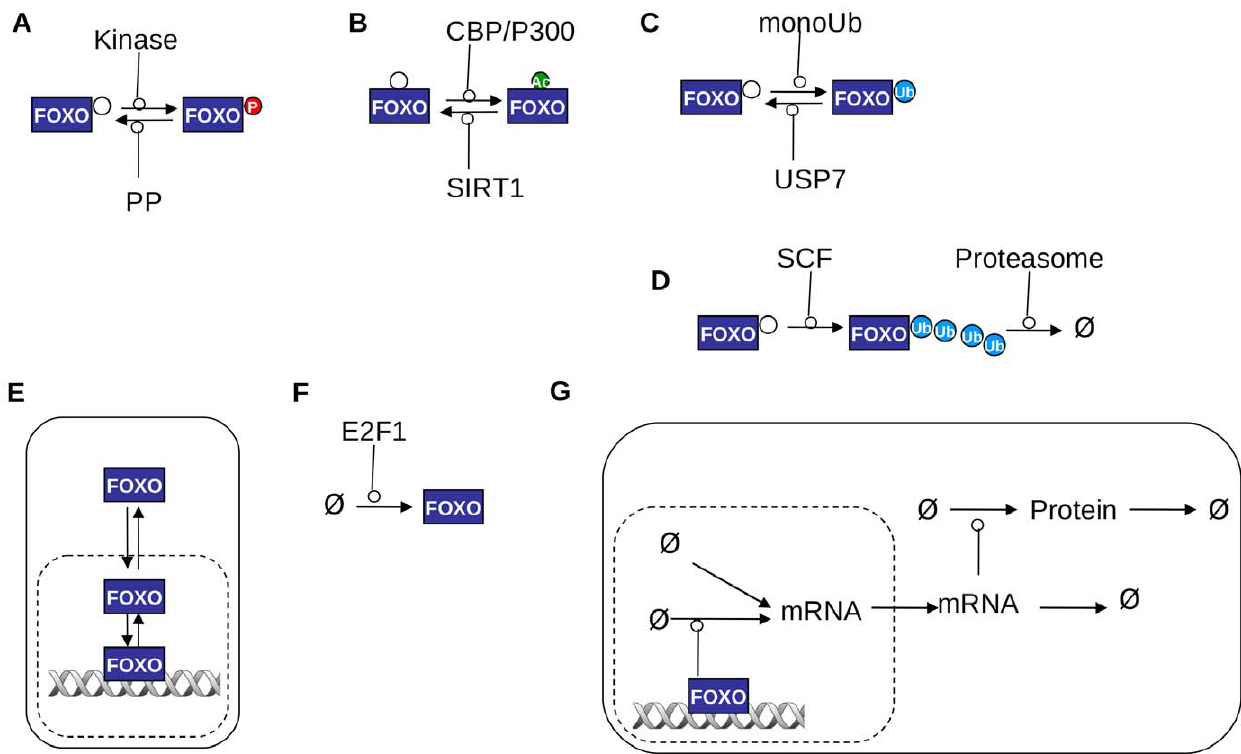
Figure 3. Fundamental reaction types in the model. A: phosphorylation/dephosphorylation; B: acetylation/deacetylation: C: monoubiquitina- tion/deubiquitination; D: polyubiquitination; E: translocation between cytoplasmic, nuclear and DNA bound states; F: synthesis; G: FOXO-dependent protein synthesis.